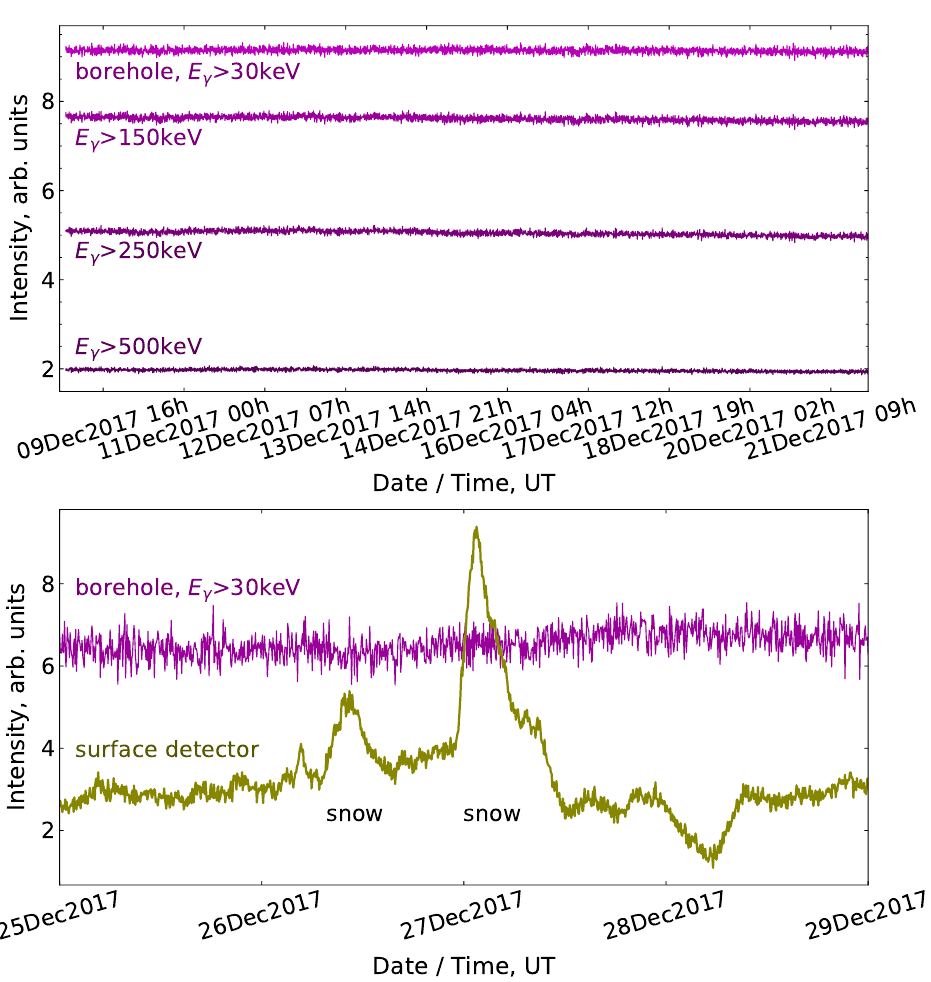
Figure 7. Smoothed records of signal intensity in the gamma detectors written before ( upper panel ) and after ( lower panel ) the rise of soft radiation on 23–24 December